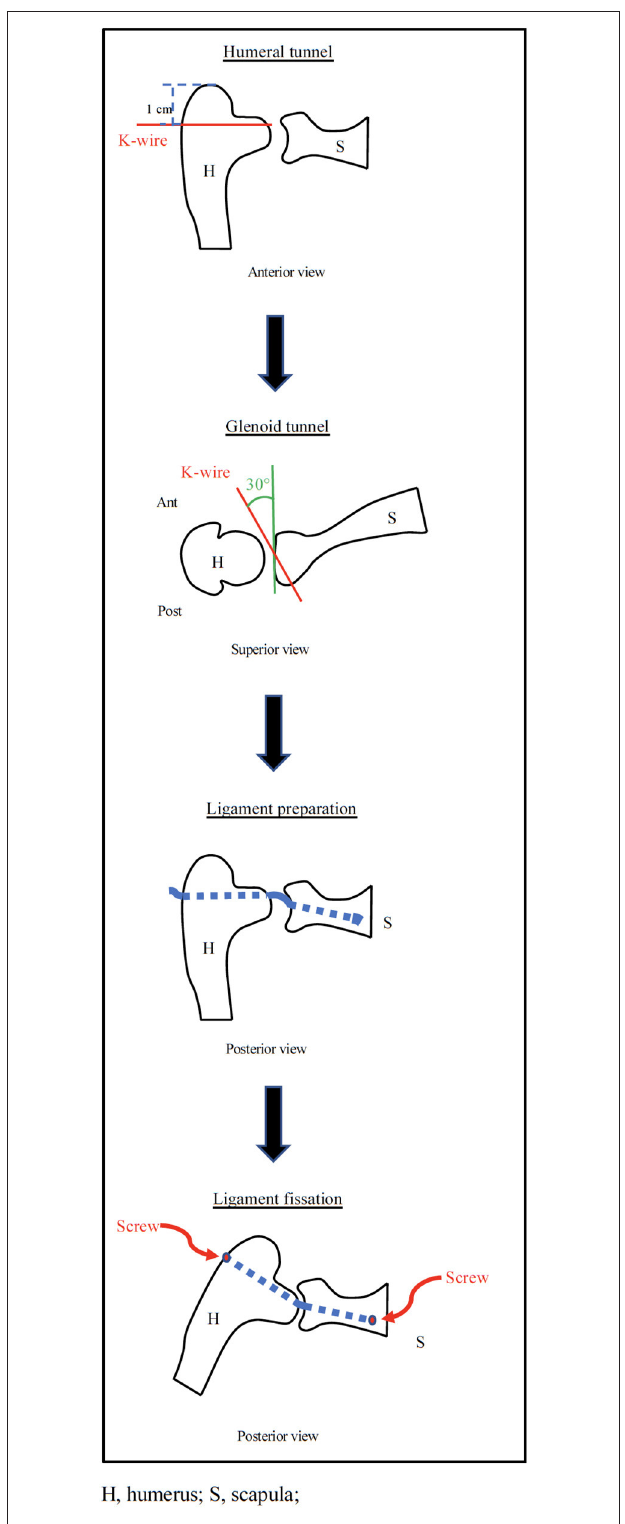
FIGURE 3 | Diagramatic representation of the AISS